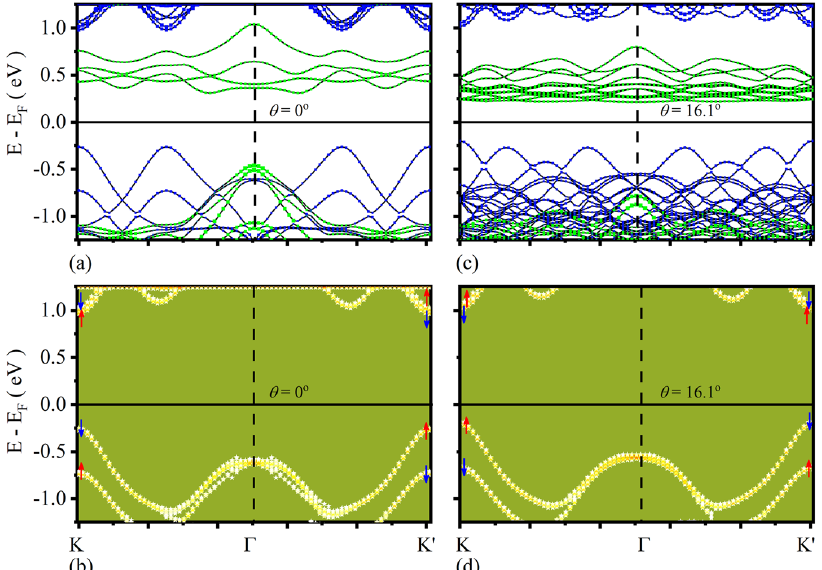
Fig. 4 Band structures of WSe 2 /CrI 3 heterostructures. a , c are the projected ones, in which green and blue denote CrI 3 and WSe 2 states, respectively. b , d are the unfolded ones for WSe 2 , in which red and blue arrows denote spin up and down states.